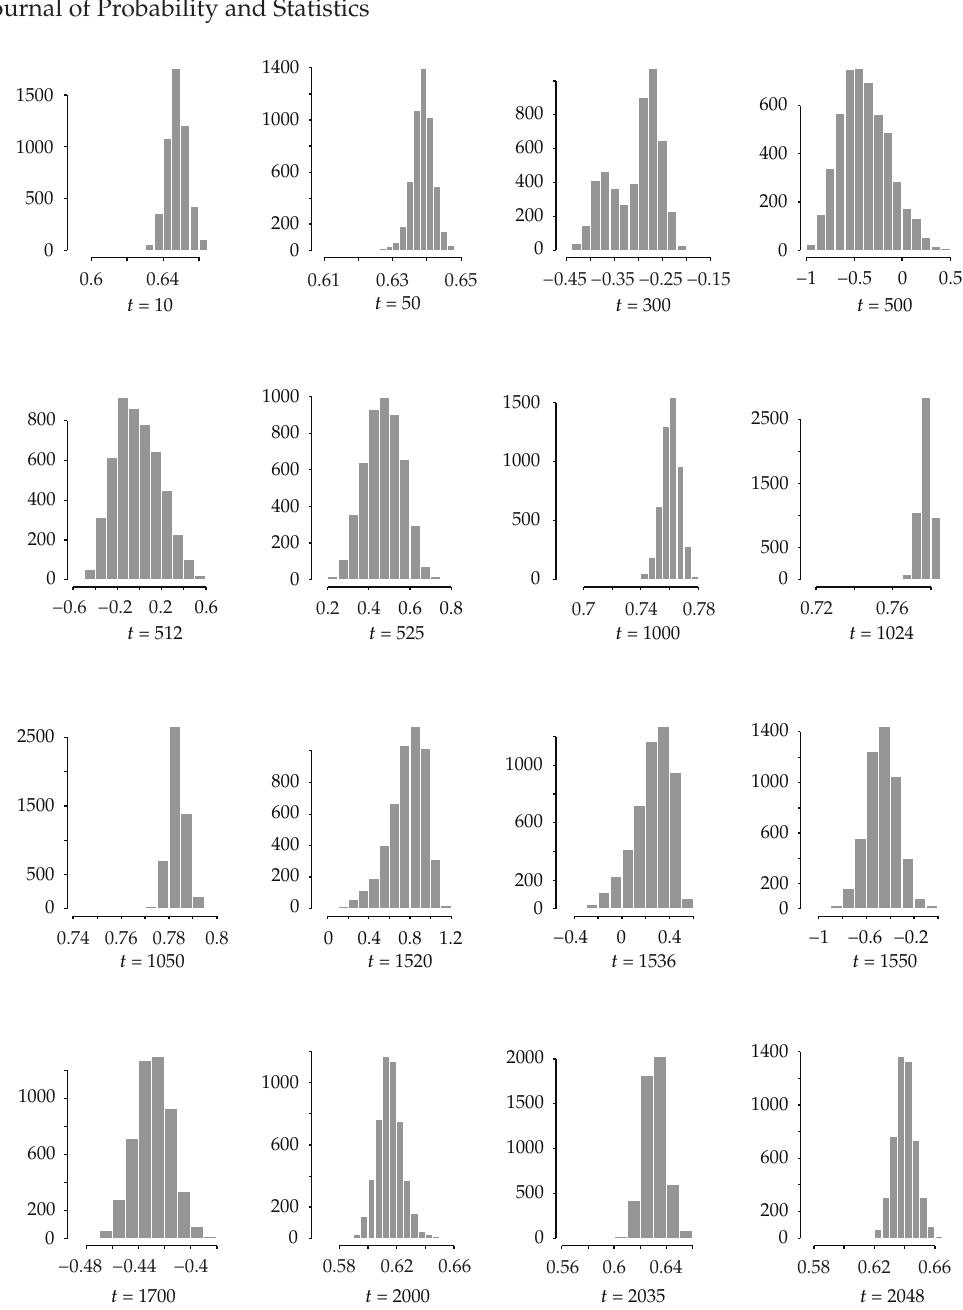
In Figure 4, we use bootstrap with B (cid:3) 300 replications to see that the true transfer function coe ffi cients lie within the 95% confidence regions. See Section 6 for the description of the bootstrap